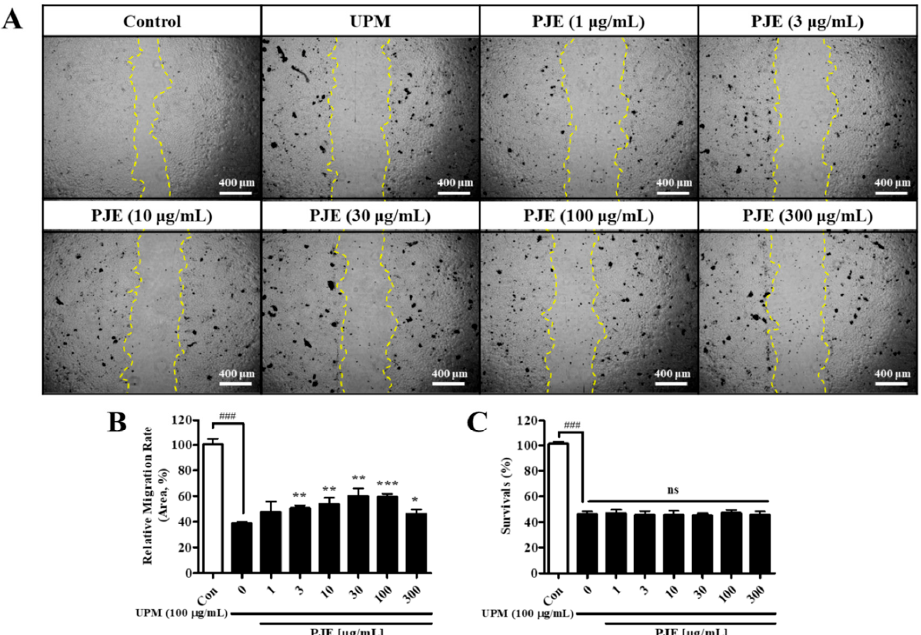
Figure 3. Effects of UPM and PJEs on the migration activity were assessed on the human corneal epithelial cells (HCECs). ( A ) A scratch was induced to the HCECs treated with UPM and various concentrations of PJE for 24 h. The closed area after 24 h from scratch area were calculated. The scale bars indicate 400 μ m. ( B ) The relative migration rates of HCECs are expressed as the means ± SD. ( C ) The survival rates of HCECs are expressed as the means ± SD. ### p < 0.001 compared to Con; * p < 0.05, ** p < 0.05, *** p < 0.001 compared to 0 μ g/mL PJE; ns, not significant.